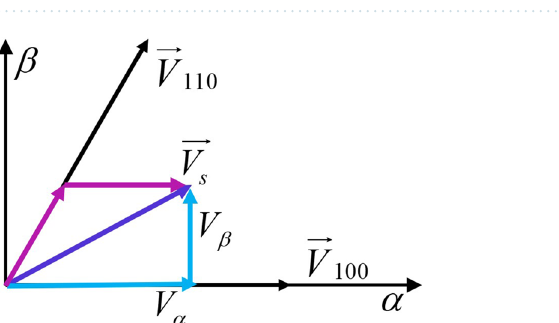
Figure 4. Vectors space distribution, V dc is the bus voltage.